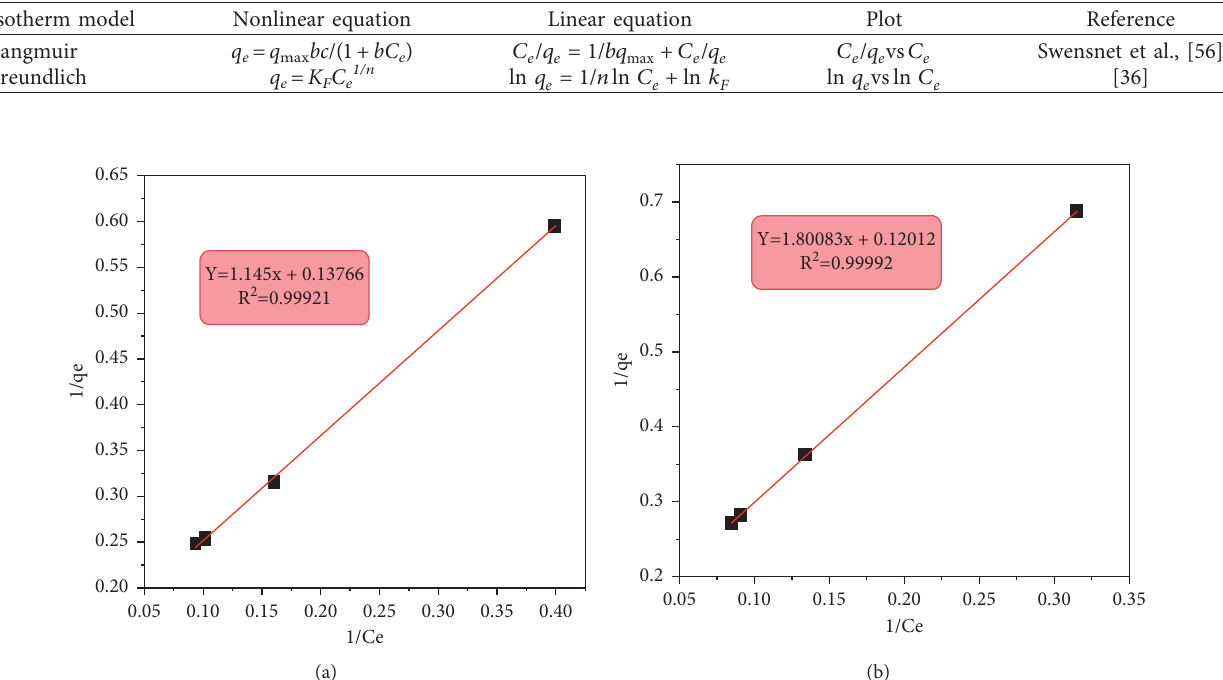
Figure 9: (a) Langmuir isotherm: a plot of 1/ q e against 1/ C e of sample Z-A. (b) Langmuir isotherm: a plot of 1/ q e against 1/ C e of sample Z-B.